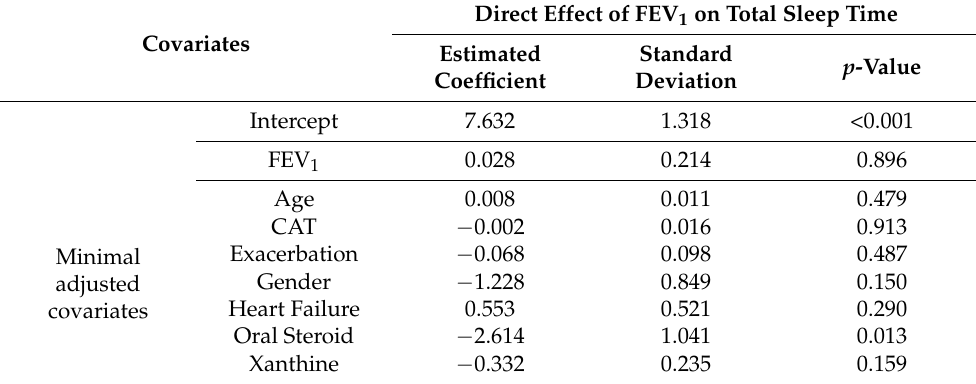
Table 5. Regression of total sleep time on FEV 1 with minimal adjusted